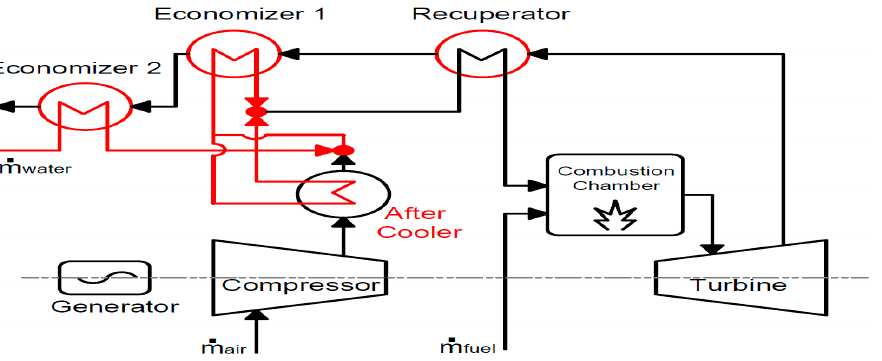
Figure 5. The REVAP cycle, combining liquid water injection with aftercooling and feedwater pre- heat with economizer 2 (adapted from [75]).